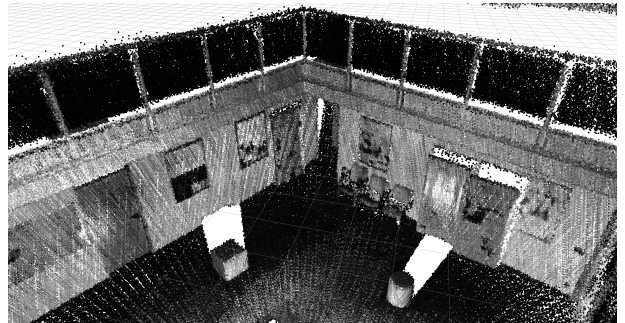
Figure 6. Point cloud of the scene, recorded to compare calibration qualities with different